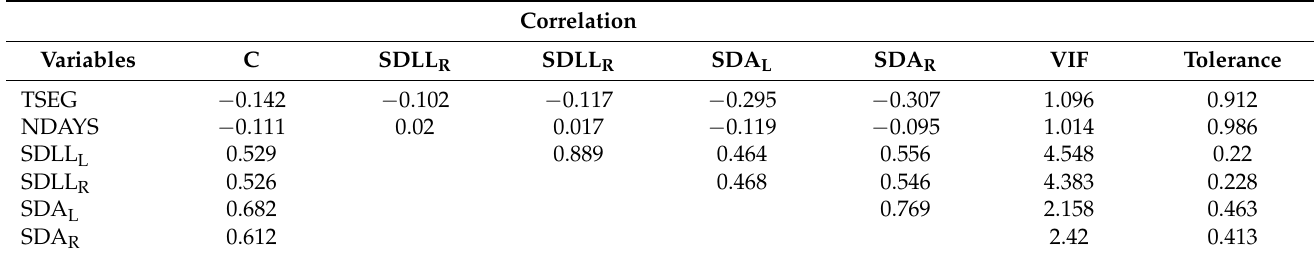
Table 3. Correlation coefficients and results of VIF and tolerance evaluation of the predictors.